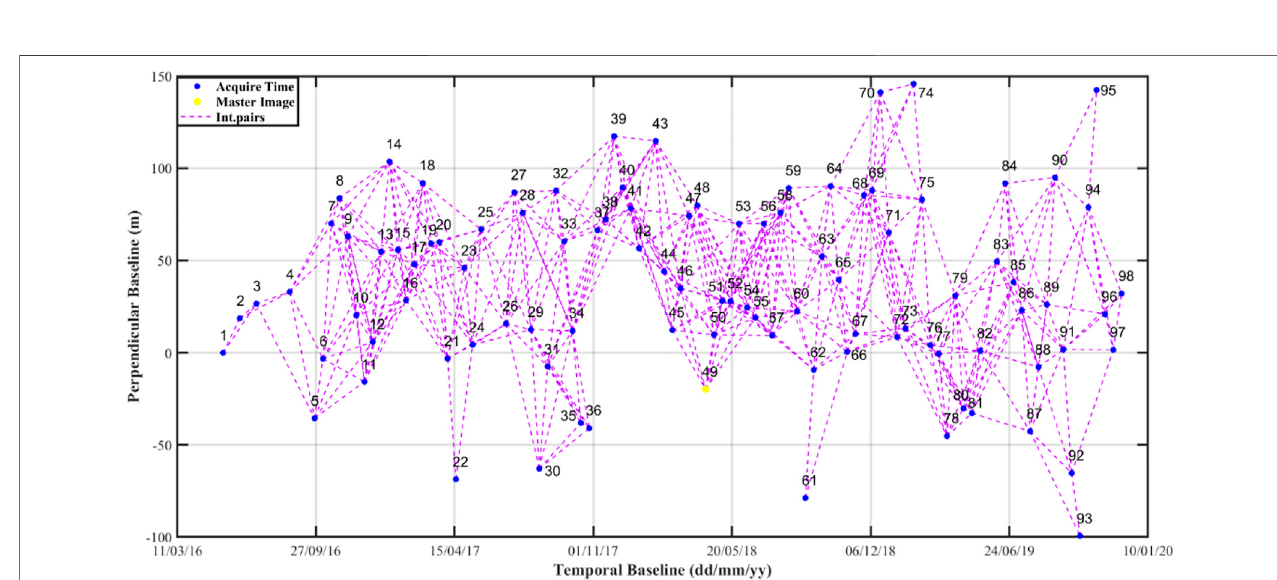
FIGURE 3 | Temporal and perpendicular baselines of the study periods. Blue dots represent the image acquisitions, and yellow dots represent the super master images. Purple dashed lines represent interferometric pairs.